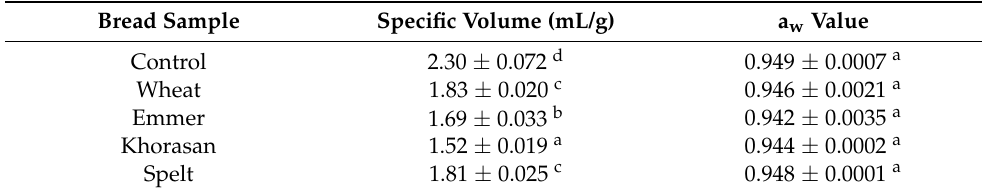
Table 1. Specific loaf volumes and crumb moisture activity (a w ) values of sourdough breads prepared from different wheat varieties in comparison with control yeast fermented wheat bread. Bread Sample Specific Volume (mL/g)